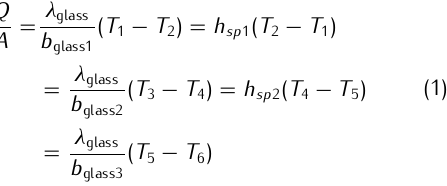
Figure 6. Heat flux measurements